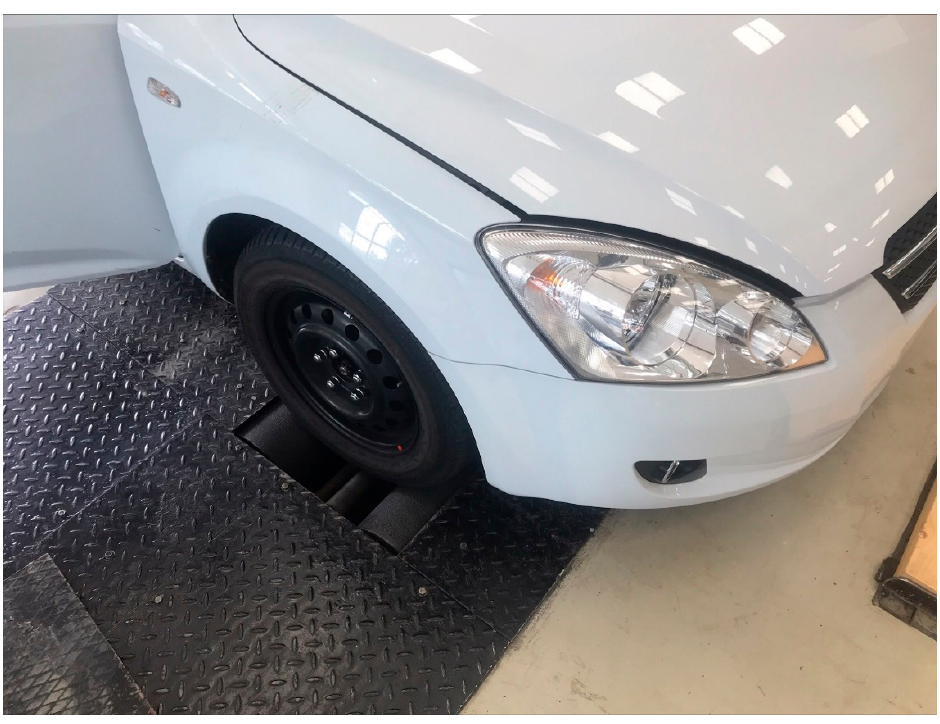
Figure 7. Motex 7547 brake test bench.